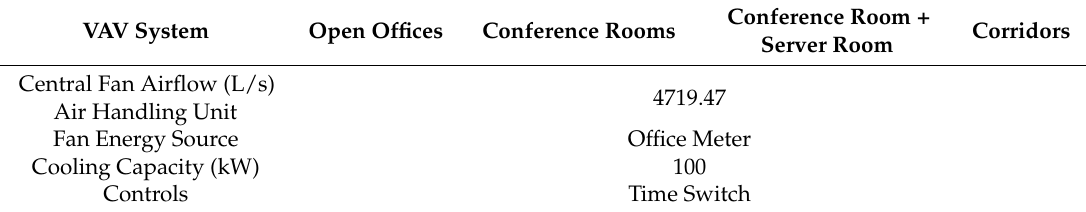
Table 10. Design variables for the Variable Air Volume (VAV) system.